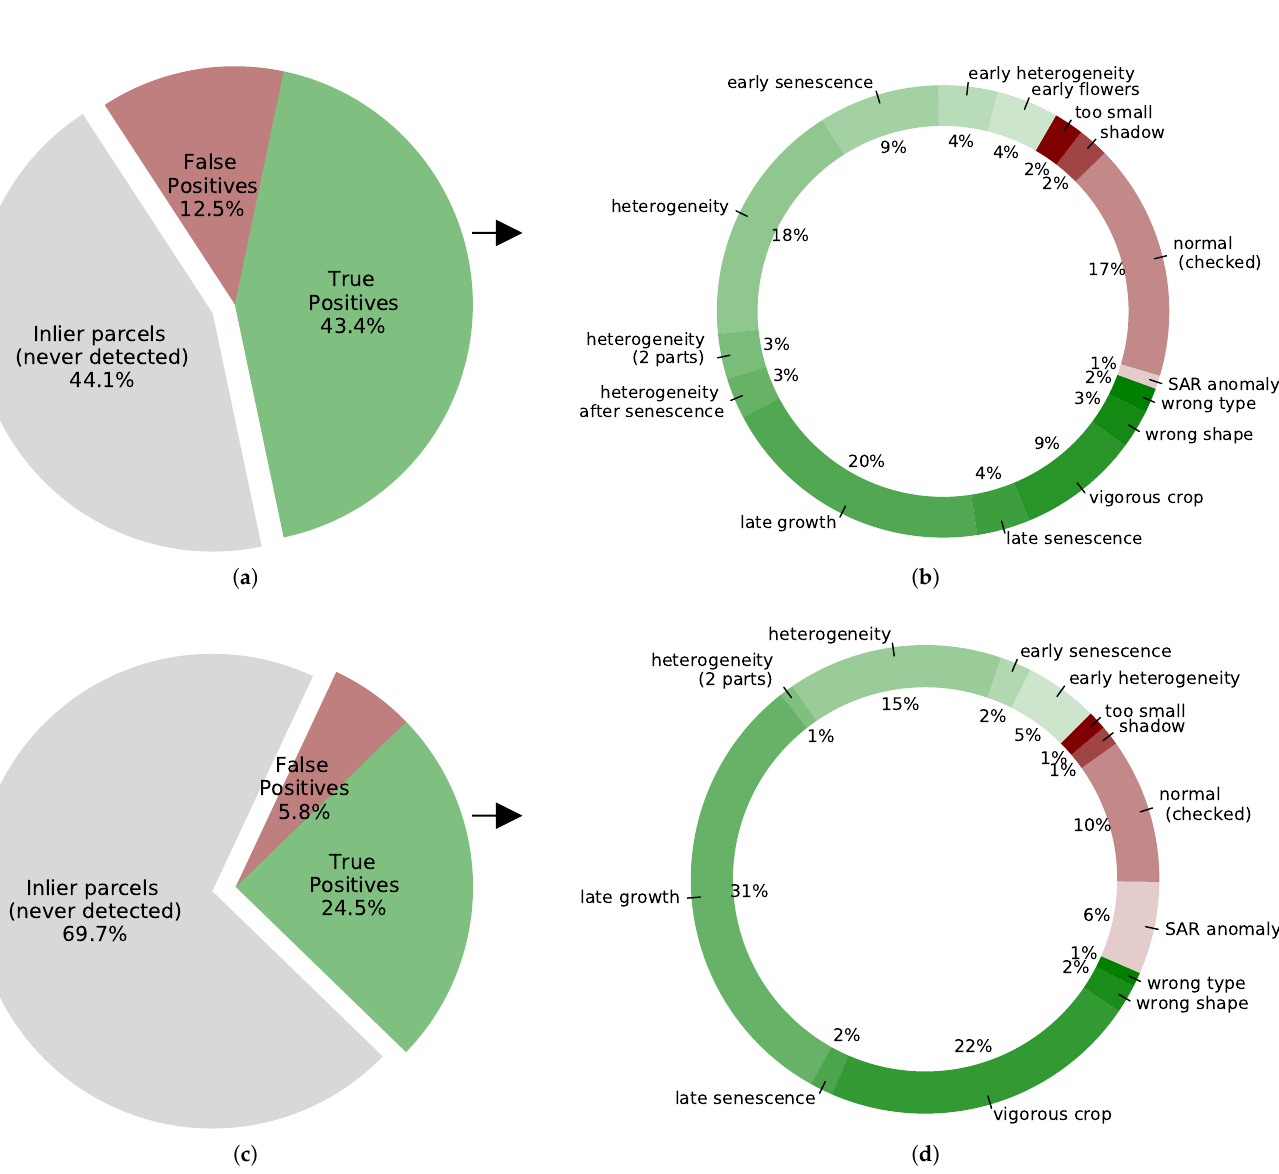
Figure 11. Distribution of the outlier parcels (labeled by experts) and the inlier parcels (never detected) for ( a , b ) rapeseed crops and ( c , d ) wheat crops. Green categories correspond to relevant anomalies considered as true positives and red categories to non-agronomic anomalies considered as not